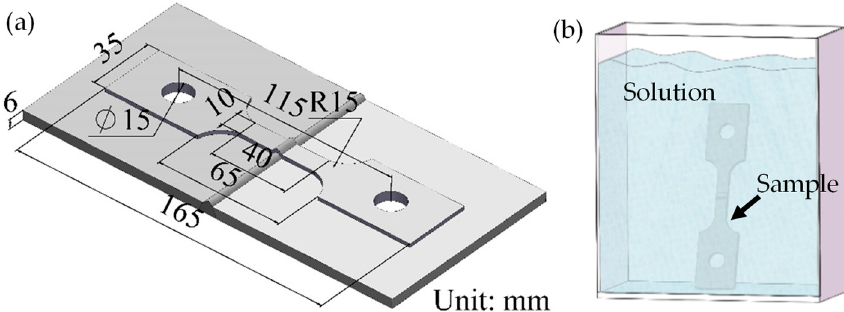
Figure 1. ( a ) Typical 5083/6005A welded joint; ( b ) Schematic representation a of the corrosion test.